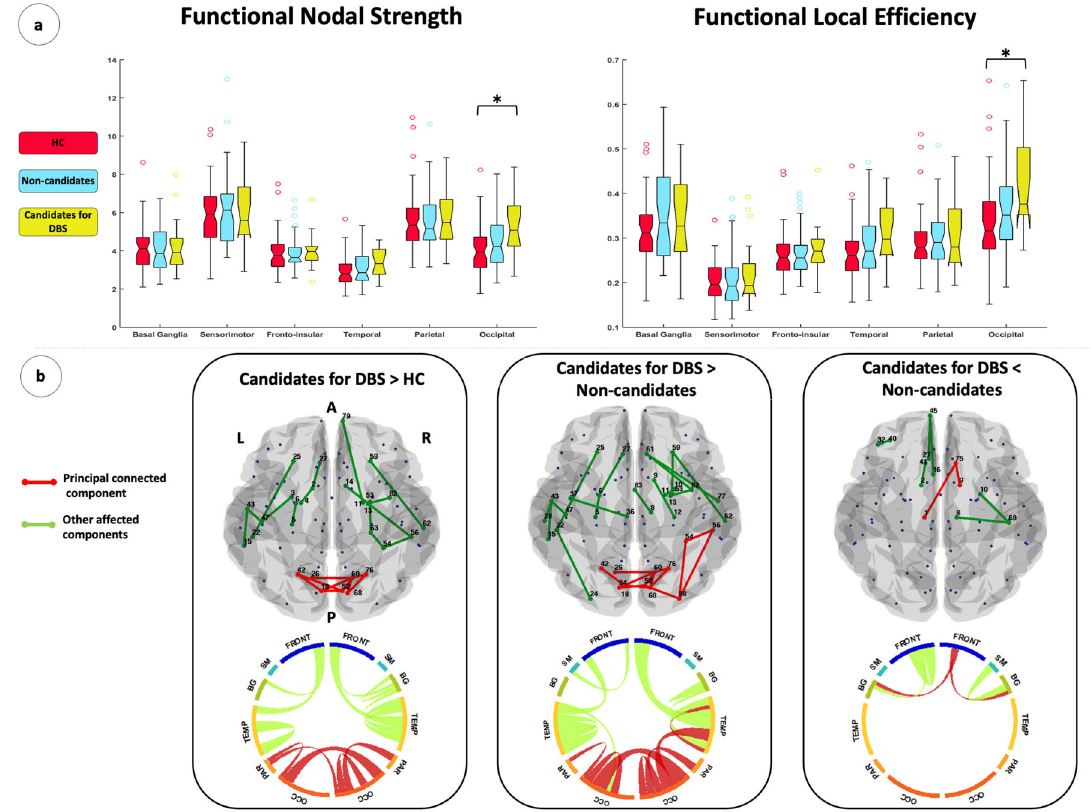
Fig. 2 Functional connectome alterations in Parkinson ’ s disease patients relative to healthy controls at baseline. a Box plot of lobar functional nodal strength and local ef fi ciency in healthy controls, patients eligible for DBS over time (Candidates for DBS), and patients not eligible for future DBS (Non-candidates). The black horizontal line in each box plot represents the median, the two lines just above and below the median represent the 25th and 75th percentiles, whiskers represent the minimum and maximum values, and all the dots outside the con fi dence interval are considered as outliers. * p < 0.05, Bonferroni-corrected for multiple comparisons. b Regional analysis results (NBS), from left to right: increased functional connectivity in candidates for DBS relative to controls; increased functional connectivity in Candidates for DBS relative to Non-candidates; decreased functional connectivity in Candidates for DBS relative to Non-candidates. In the upper part of the B section, abnormal functional connections are represented in a glass brain. In the lower part, lobar regions are arranged as a ring (the size of the regions are proportional to the number of the nodes included). The principal (or largest) connected components are shown in red; other connected components, not included in the principal connected components, are shown in green. Supplementary Table 2 reports affected functional connection values as well as corresponding statistical signi fi cance values. Supplementary Table 5 reports the names of each brain node with the corresponding number. A anterior, BG basal ganglia, Candidates for DBS patients eligible for DBS, FRONT frontal, HC healthy controls, L left, Non-candidates patients not candidate to DBS, OCC occipital, PAR parietal, P posterior, R right, SM sensorimotor, TEMP